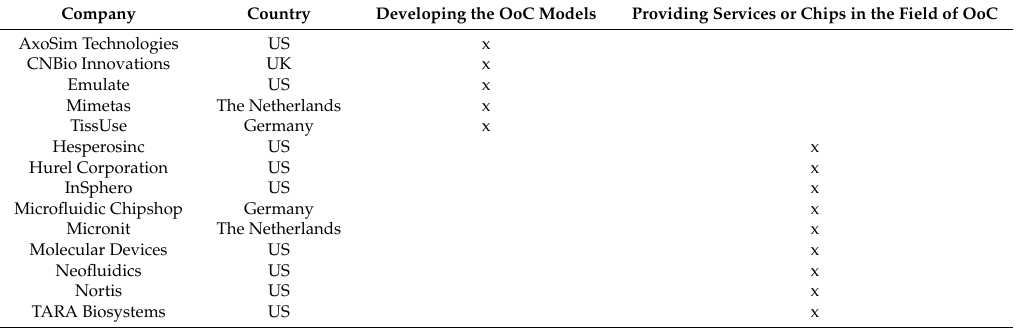
Figure 1. An example of the information provided by air monitoring stations in Beijing, China. Besides the usual temperature, dew, pressure, humidity, and wind values in hourly readings, the information on following pollutants can be seen: particular matter 2.5 (PM2.5), PM10, O 3 , NO 2 , SO 2 , and CO. Here, the unhealthy status is based on current highest PM2.5 values. The figure is reproduced with permission [11]. Table 1. A non-exhaustive list of companies engaged in Organ-on-Chip (OoC) development or providing services in this